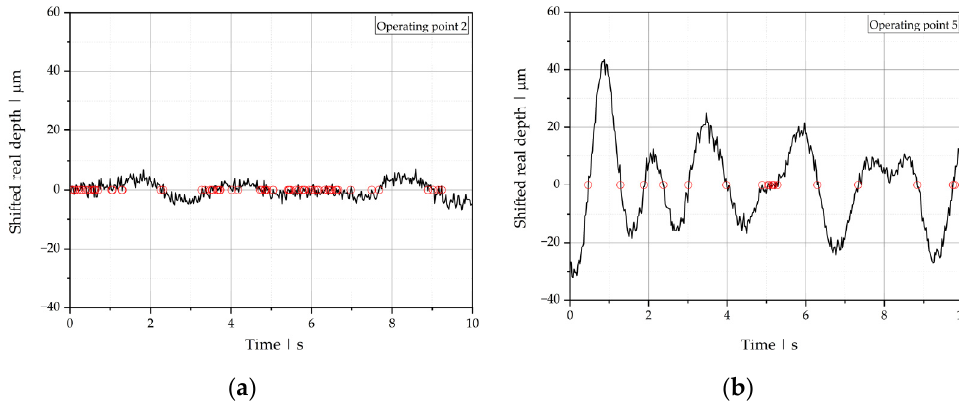
Figure 13. Number of zero-crossings of the real depth position of the polymer-polymer interface over time, shifted by the mean, for ( a ) operating point 2 and ( b ) operating point 5.